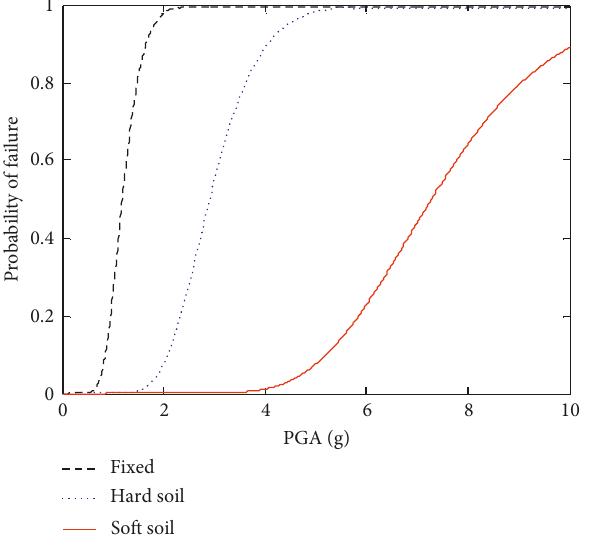
Figure 11: Comparison of median seismic hazard curves: fixed, hard soil, and soft soil conditions (case 1).